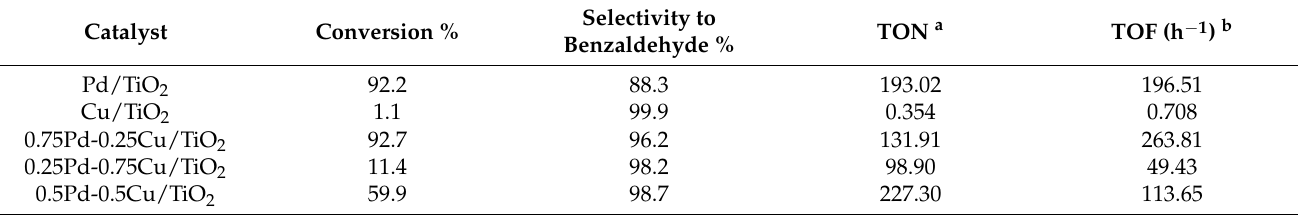
Selectivity to TON a TOF (h − 1 ) b Benzaldehyde %